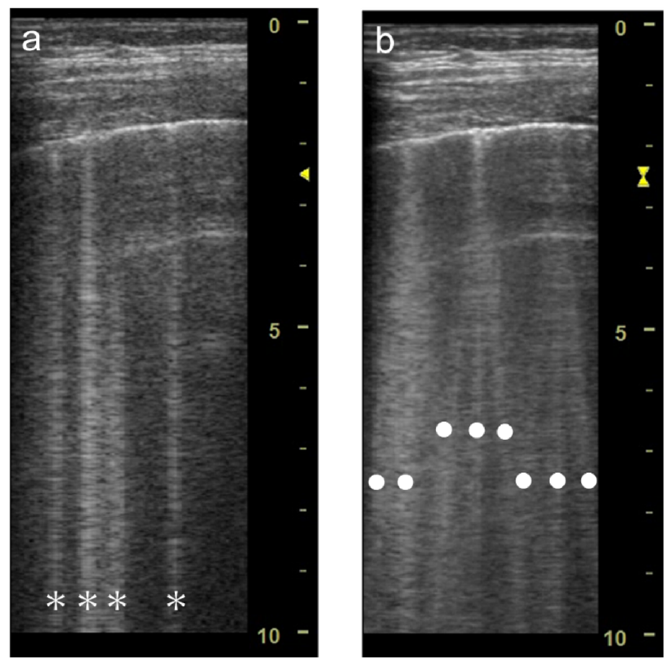
Figure 4. Ultrasound images obtained by LOGIQ V scanner (GE Healthcare) with a linear transducer without ( a ) and with spatial compound imaging ( b ) in cardiogenic pulmonary edema. With spatial compound imaging enabled, each single B-line (asterisks) changes to multiple lines (dots) radiating from the same point on the pleural line.